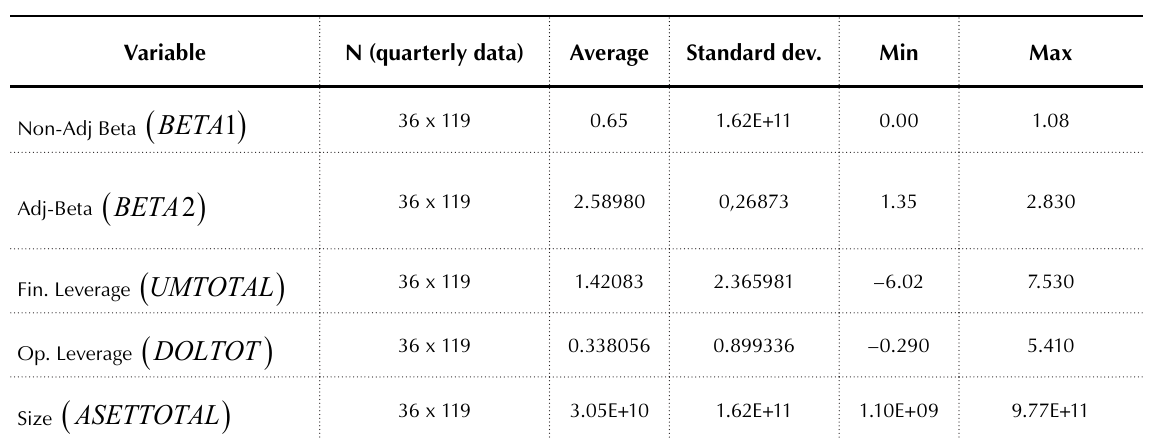
Tabel 1b. Descriptive statistics for temporal data